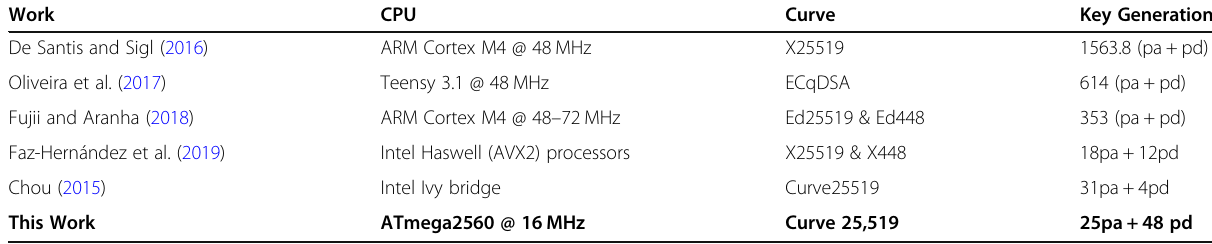
Table 6 Curve operation performance comparison for 128-bit key generation Work Curve